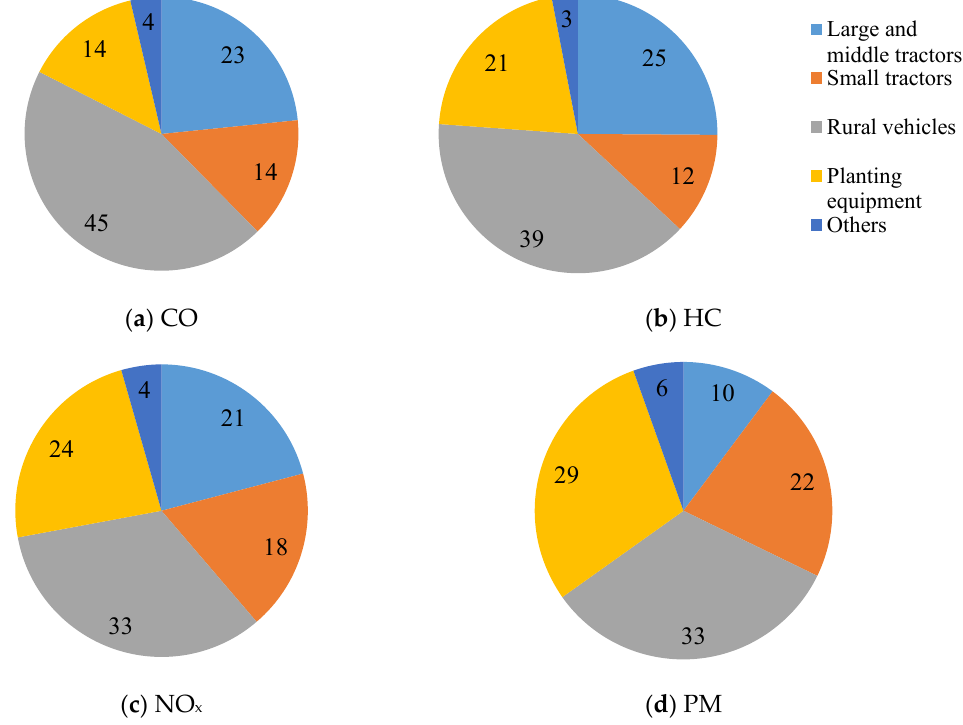
Figure 3. Contributions (%) of emission from different agricultural machinery types to total emissions in Anhui in 2013.